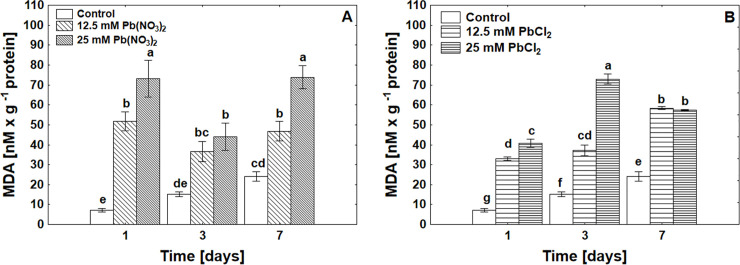
Malondialdehyde (MDA) content in P. sylvestris seeds under control, Pb(NO3)2 (A) or PbCl2 (B) treatments in concentrations of 12.5 mM and 25 mM after 1, 3 and 7 days of germination, ANOVA, Duncan Test p≤0.05.